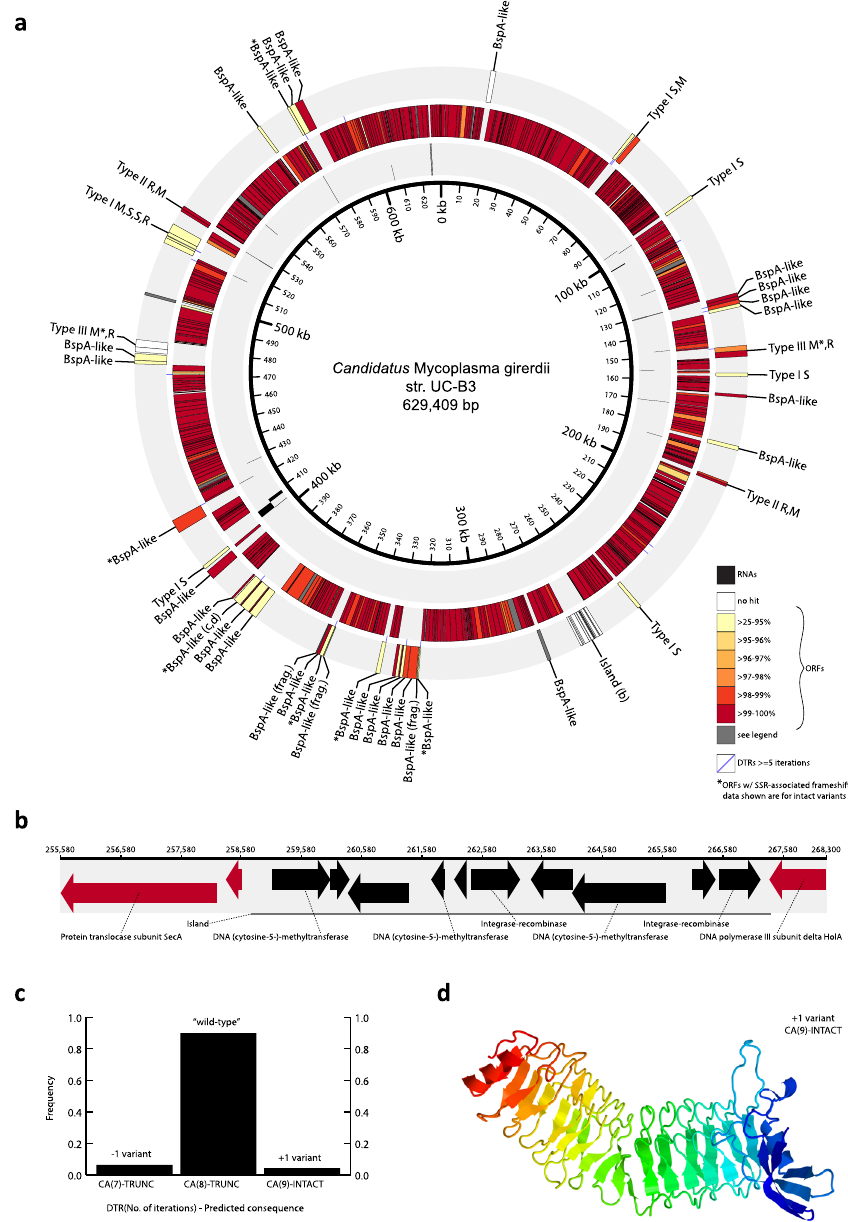
Figure 3. Genomic features distinguishing Ca . M. girerdii strain UC-B3 from strain VCU-M1 include those with evidence of phase variation within population UC-B3. ( a ) Circular genome map of Ca . M. girerdii strain UC-B3. Inner track shows RNA genes (black; staggered for clarity). Center and outer tracks show open reading frames (ORFs; color graded on percent amino acid identity to reciprocal best hit in VCU-M1). ORFs in gray have a close nucleotide hit in strain VCU-M1 but were not predicted there by the authors. Purple lines, located between center and outer tracks, represent dinucleotide tandem repeats (DTRs) of five or more iterations (Supplementary Table S6). ORFs from variable classes were manually placed in the outer track. Those with asterisks display evidence of phase variation (Supplementary Table S7); those without labels (n = 5) encode fructose-bisphosphate aldolase; and those composing restriction modification systems are labeled clockwise as follows: R, restriction endonuclease; M, modification methylase; S, specificity subunit. The subjects of panels b–d are labeled in bold. SSR, simple sequence repeat. ( b ) Linear map detailing genomic island in UC-B3, which is absent from VCU-M1. ORFs drawn as arrows; those without labels encode hypothetical proteins. ( c ) Evidence of phase variation for selected feature no. 11 in Supplementary Table S7. Plotted are length variant frequencies for DTR ‘CA’ associated with BspA-like protein labeled in bold in panel a. Homologous ORF in VCU-M1 contains CA(10) (Supplementary Table S7). TRUNC, frameshift-induced premature stop codon resulting in truncated BspA-like protein; INTACT, likely produces intact BspA-like protein shown in panel (d). The intact protein was modeled against the highest scoring template (pneumococcal vaccine antigen PcpA) using Phyre2 55 . Left/red, N-terminus; right/blue,